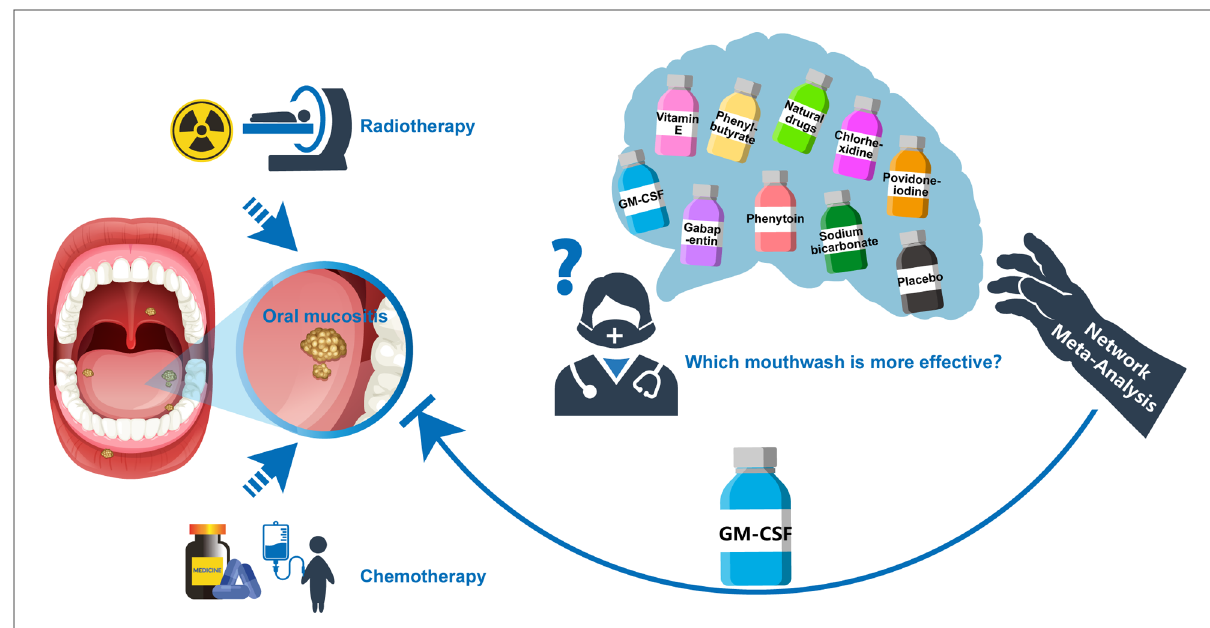
FIGURE 1 The summarised diagram of this Bayesian network meta-analysis. Abbreviations: GM-CSF, granulocyte-macrophage colony-stimulating